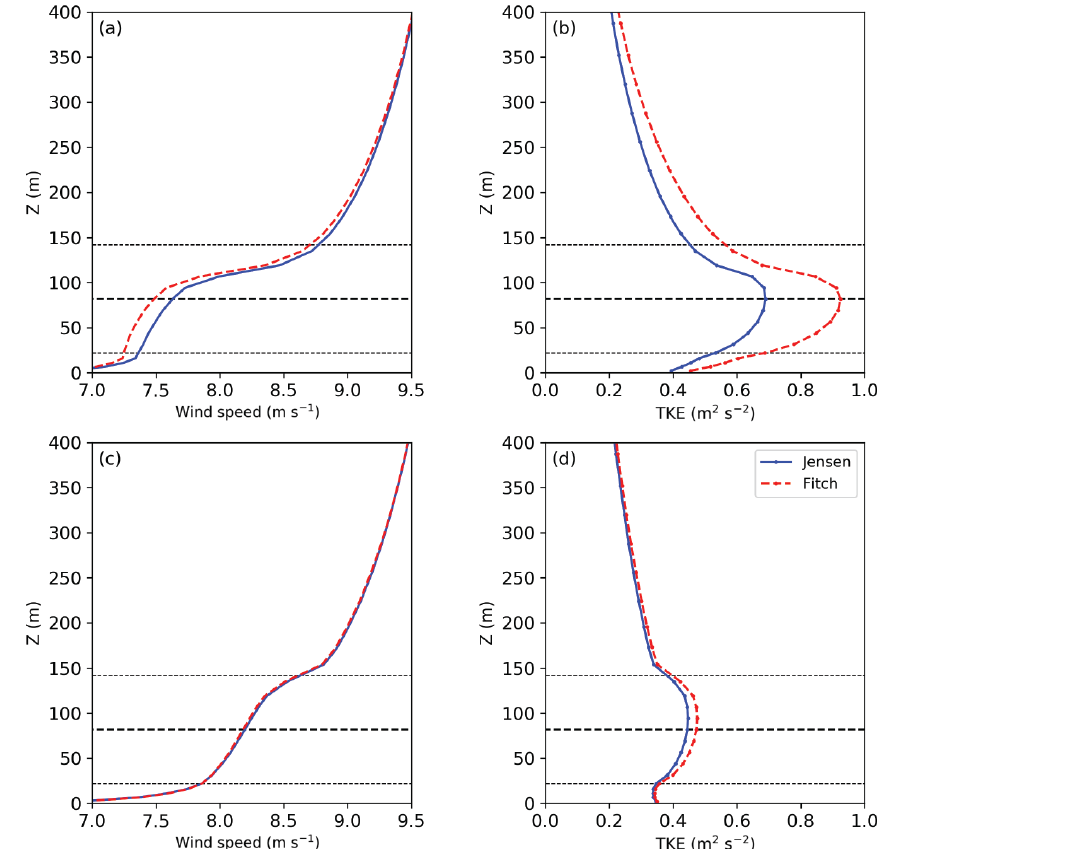
Figure 12. Vertical profiles of wind speed (a, c) and TKE (b, d) by the Fitch and Jensen parameterizations from WRF single-cell cases, 222 ◦ at Lillgrund (a, b) and 168 ◦ at Anholt (c, d)